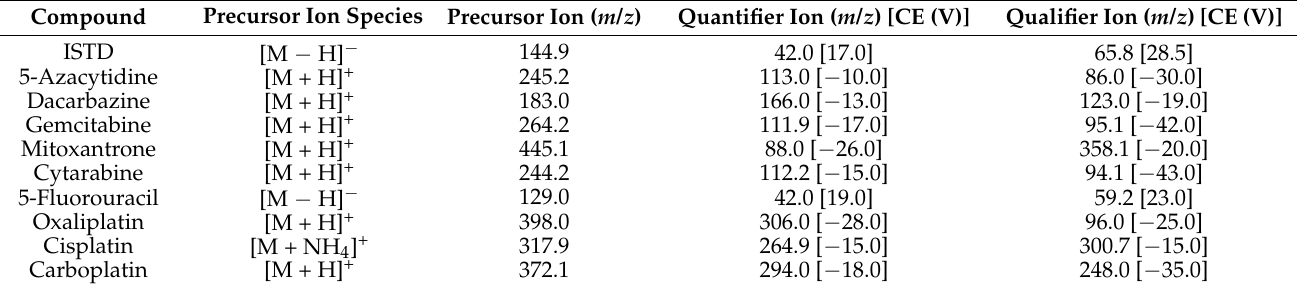
Table 1. Optimized parameters set in MRM mode, showing the quantifier and qualifier ions for each analyte with the corresponding collision energy